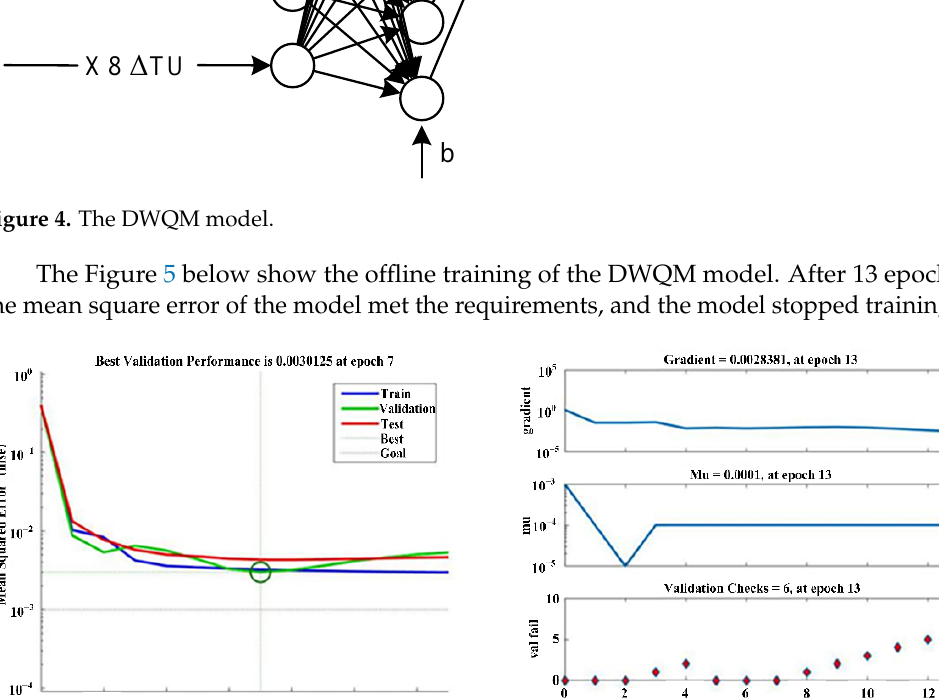
Figure 5. Training error curve of the DWQM model.